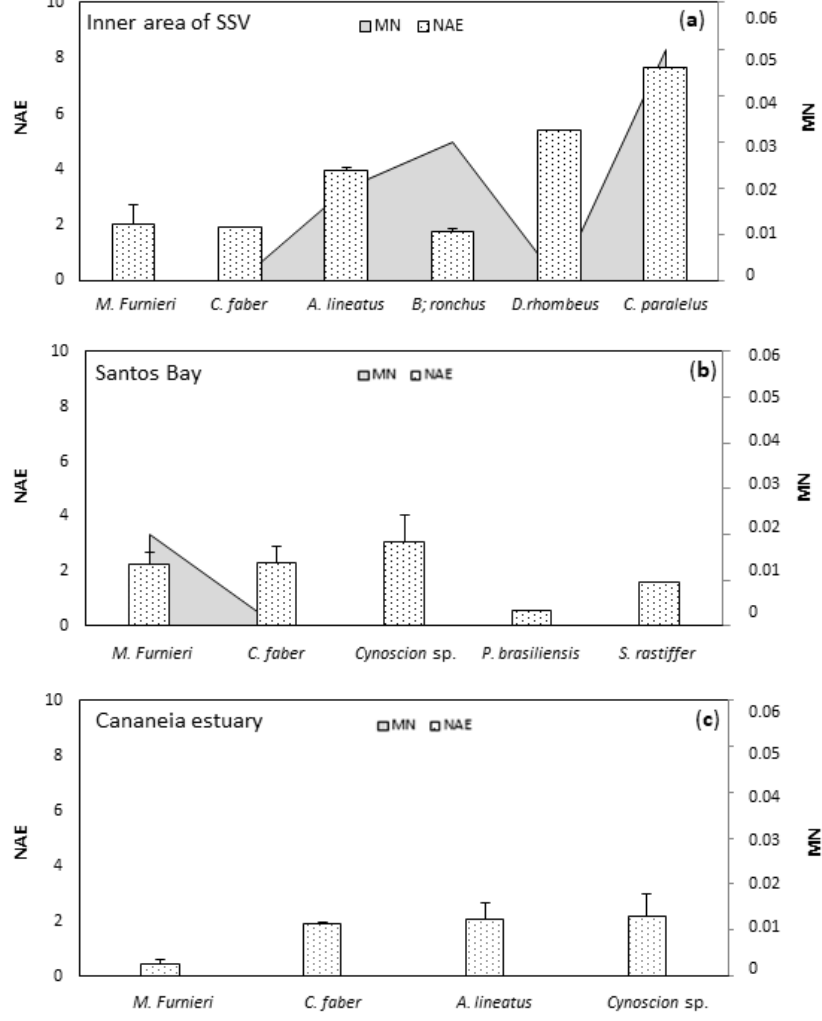
Figure 3 - Frequency of micronucleus (MN) and total of nuclear abnormalities in erythrocytes (NAE) of some fish species from the inner area ( a ) of the Bay ( b ) of the SSV estuary and from the Cananeia estuarine system ( c